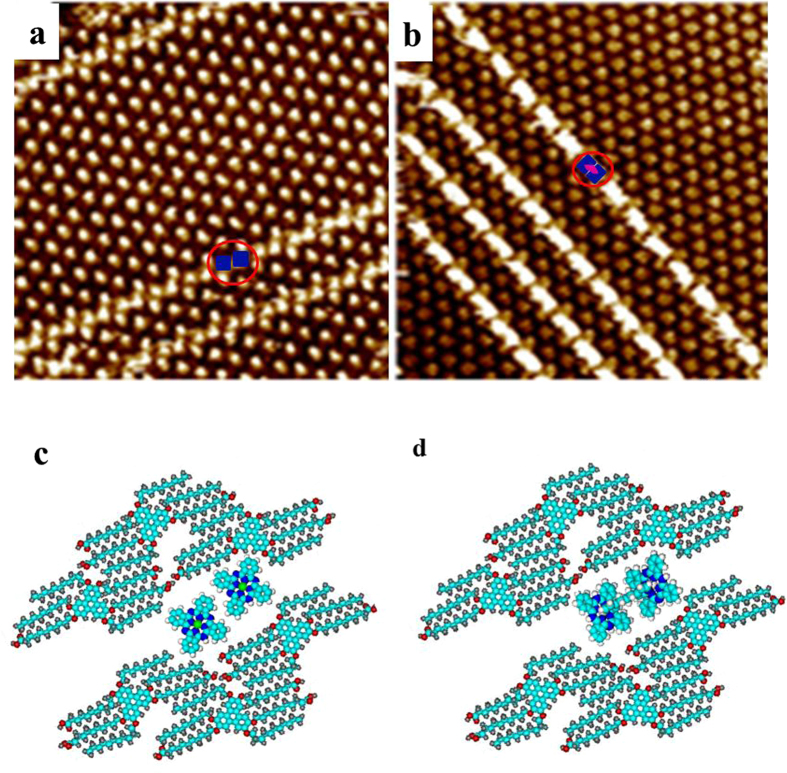
(a) STM image showing assembled structure of asym-TTT/Zn-Pc (42.2 nm × 42.2 nm, Iset = 198.4 pA, Vbias = 600.0 mV). (b) STM image showing entirely assembled structure of asym-TTT /Zn-Pc/dipy-pra system after the dipy-pra molecule was added (37.9 nm × 37.9 nm, Iset = 247.1 pA, Vbias = 1037 mV). (c) Molecular model for the observed area in (a). (d) Molecular model for the observed area in (b).